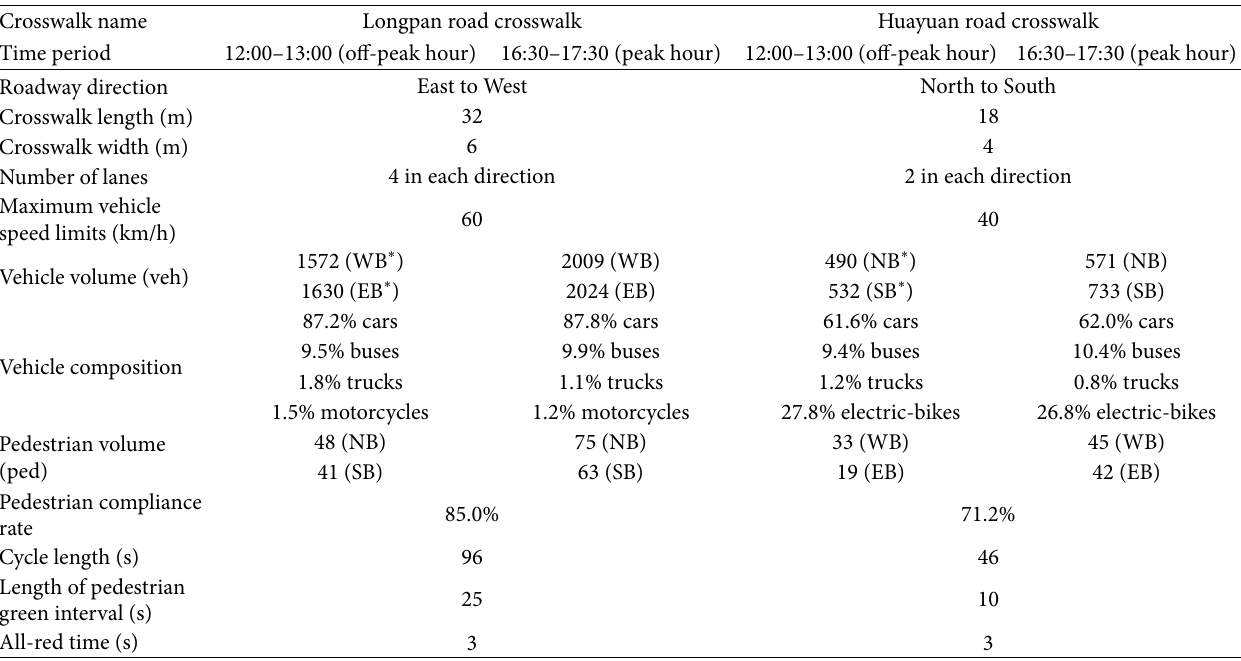
Figure 3: Satellite views of Longpan road crosswalk and Huayuan road crosswalk. Table 1: Basic information of two investigated crosswalks in the city of